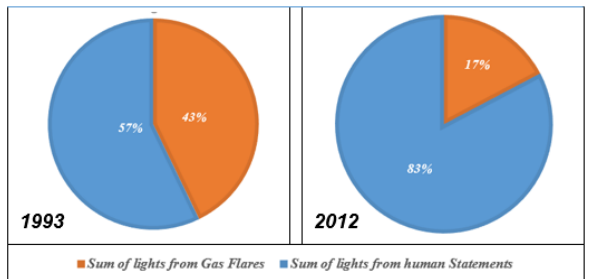
Figure 6. Changes the sources light emissions in Algeria.